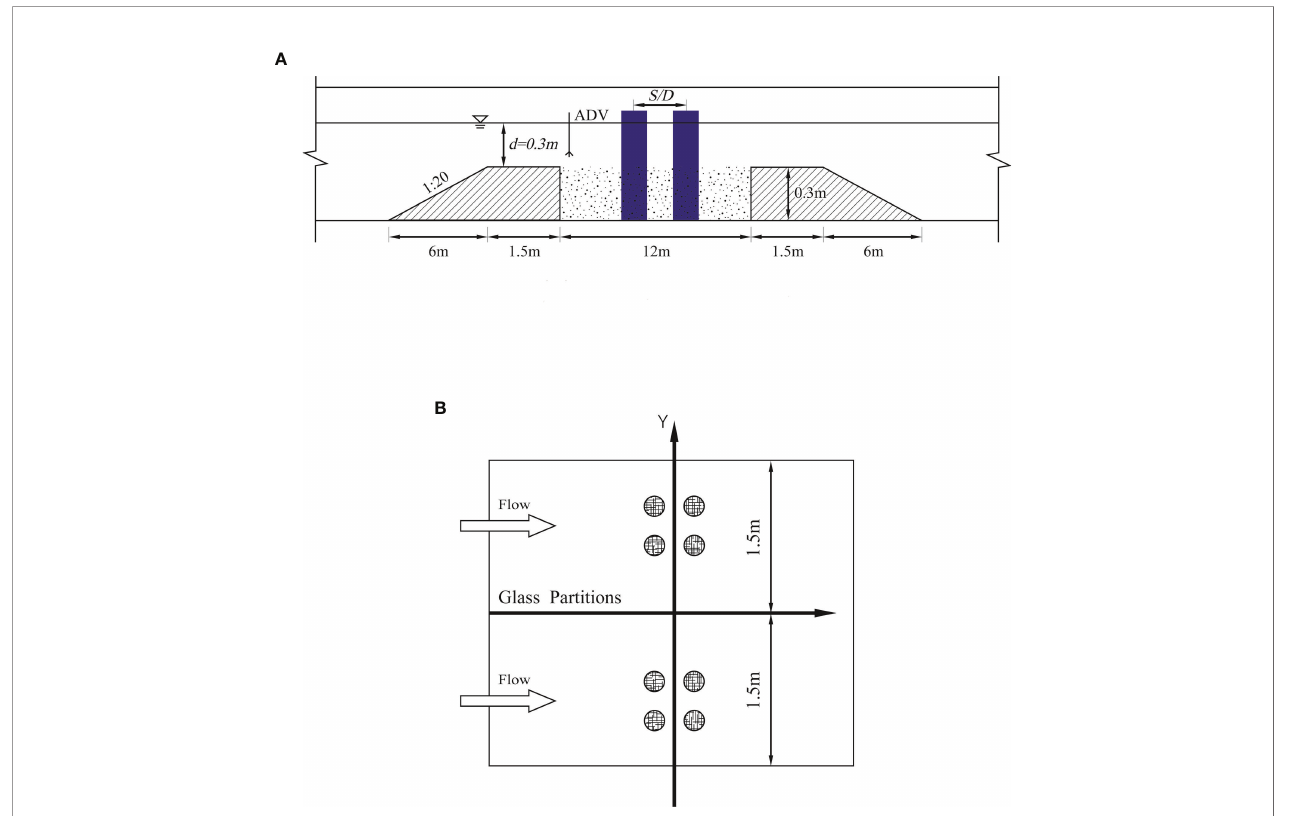
FIGURE 1 | Side view of the fl ume (A) and top view of sand recession (B)